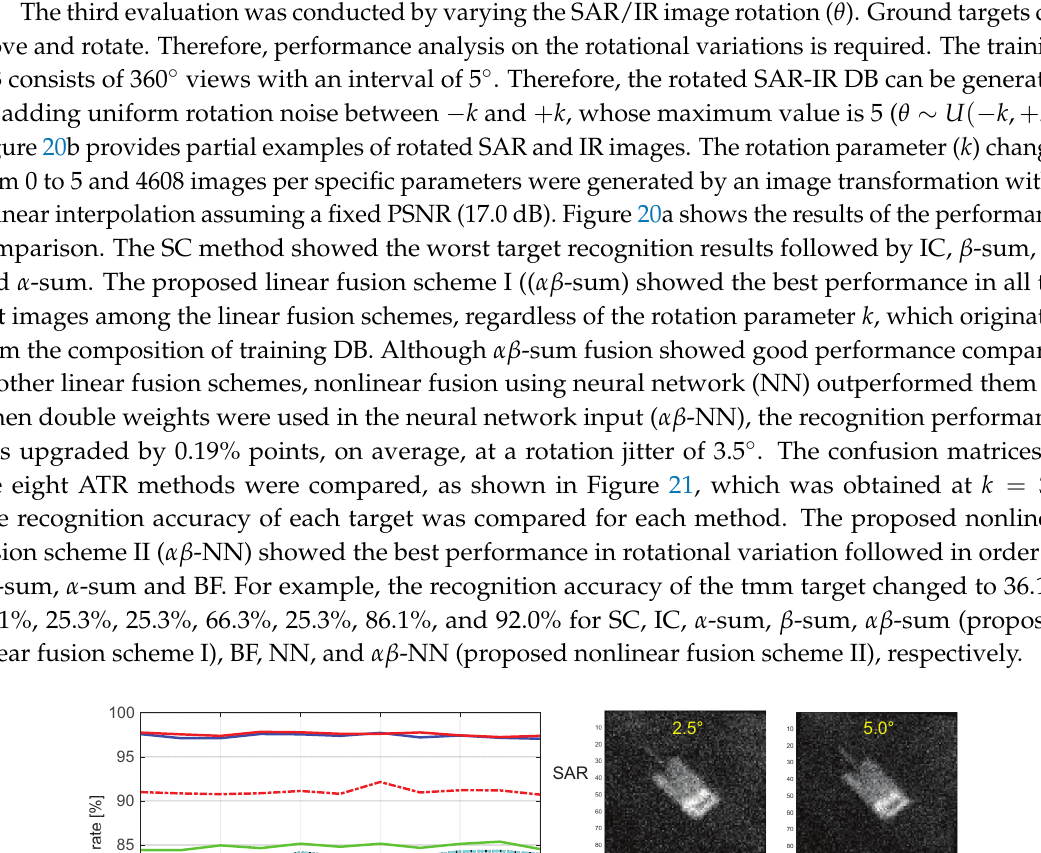
Figure 19. Confusion matrices at a blur level σ = 2.7: ( a ) SC; ( b ) IC; ( c ) α -sum; ( d ) β -sum; ( e ) αβ -sum (the proposed linear fusion scheme I); ( f ) BF [57]; ( g ) NN; and ( h ) αβ -NN (the proposed nonlinear fusion scheme II).